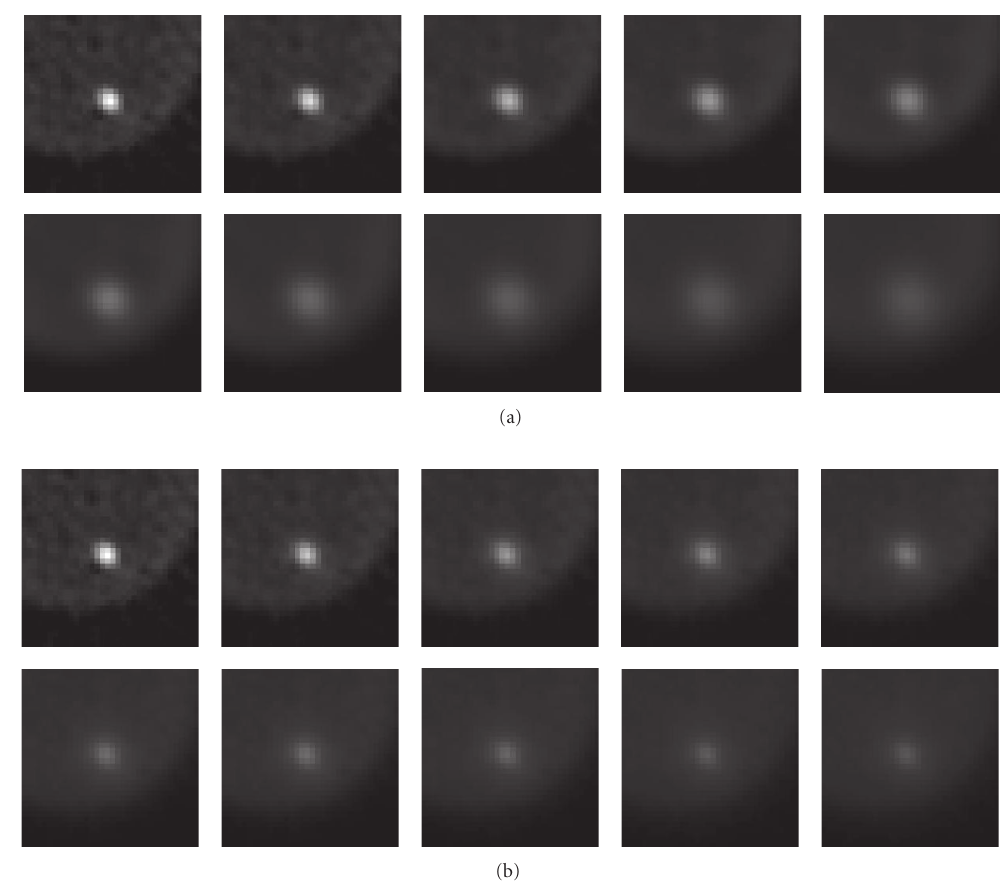
Figure 8: The hotspot data smoothed with the di ff erent Gaussian lowpass filters for the compared methods. In (a), cropped FBP images for radial sinogram filtering. In (b), the corresponding images for angular stackgram filtering. The filter kernel width of σ increases from left to right at each row in both